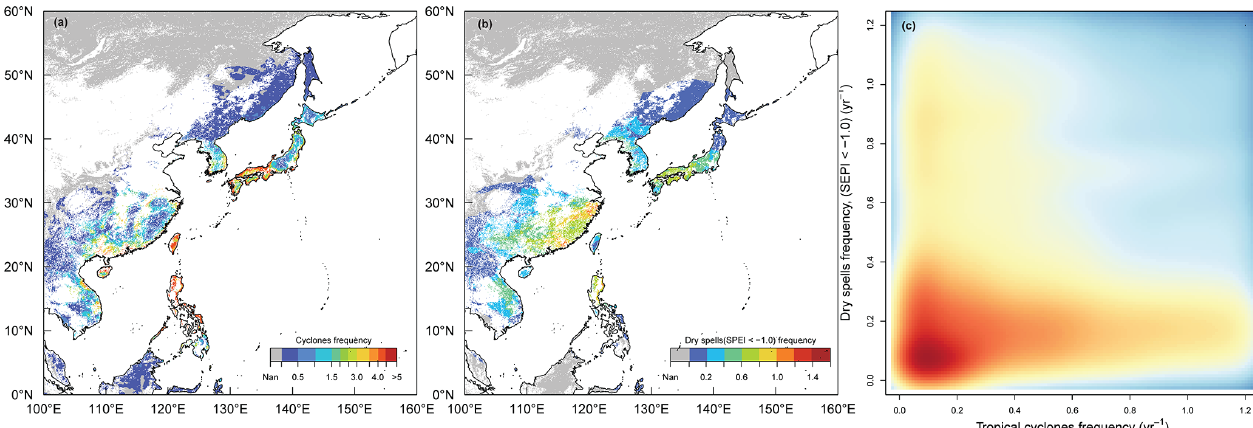
Figure 2. Spatial distribution of cyclone frequency, frequency of dry spells with a standardized precipitation and evaporation index below − 1, and their correlation. (a) Return frequency (yr − 1 ) of tropical cyclones between 1999 and 2018 following a combined wind–precipitation definition considering three diameters to define the width of the storm track (definition 3a in Table A1). (b) Return frequency (yr − 1 ) of dry spells between 1999 and 2018 following the same definition. (c) Smoothed density plot of the relationship ( r ∼ 0.11) between the return frequency of cyclones and dry spells. High-density regions are shown in warm colors compared to the cold colors used to indicate low-density regions. The density plot is based on all nine definitions for affected areas (Table A1).